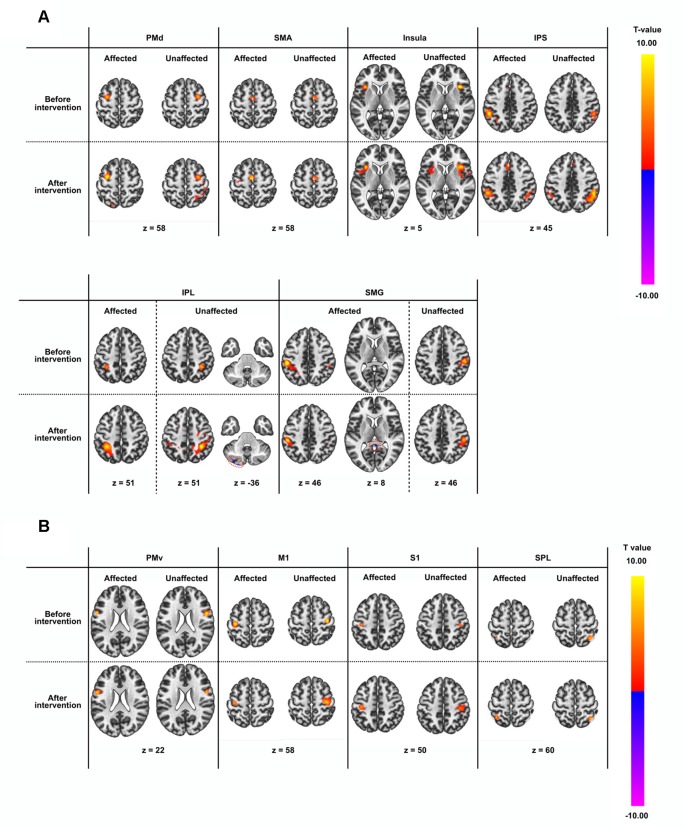
Results of seed-based functional connectivity in all regions-of-interest (ROIs). ROI names are defined in Table 2. Results before and after the intervention are displayed in rows, while those in the affected and unaffected hemispheres are displayed in columns. All connectivity maps were thresholded at voxel level false-discovery-rate (FDR) corrected at p < 0.01 and at cluster level FDR corrected at p < 0.0001. (A) ROIs showing significant intrahemispheric or interhemispheric resting-state brain functional connectivity (rsFC). (B) ROIs not showing significant intrahemispheric or interhemispheric rsFC apart from the rsFC to themselves.